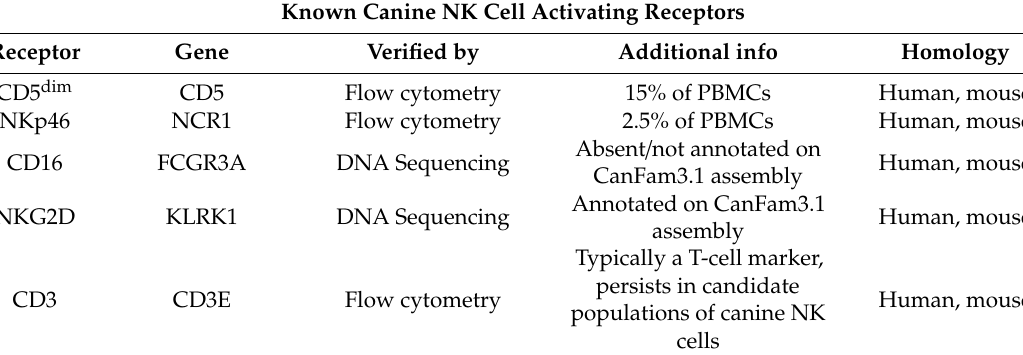
Table 1. Phenotypic Surface Markers of Canine NK Cells based on Current Evidence. Known Canine NK Cell Activating